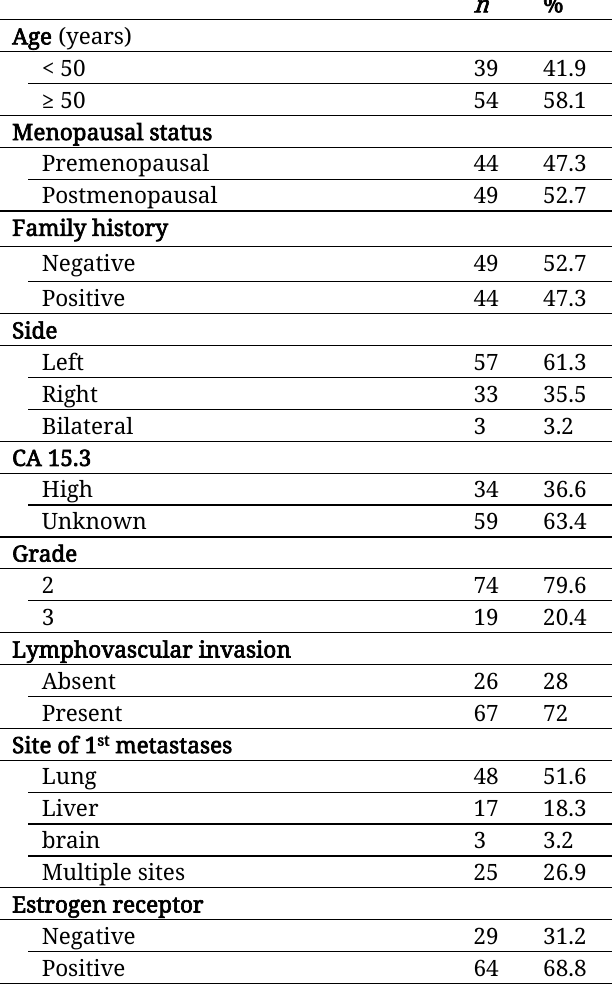
Table 1: Patient and tumor characteristics and immunohistochemistry results